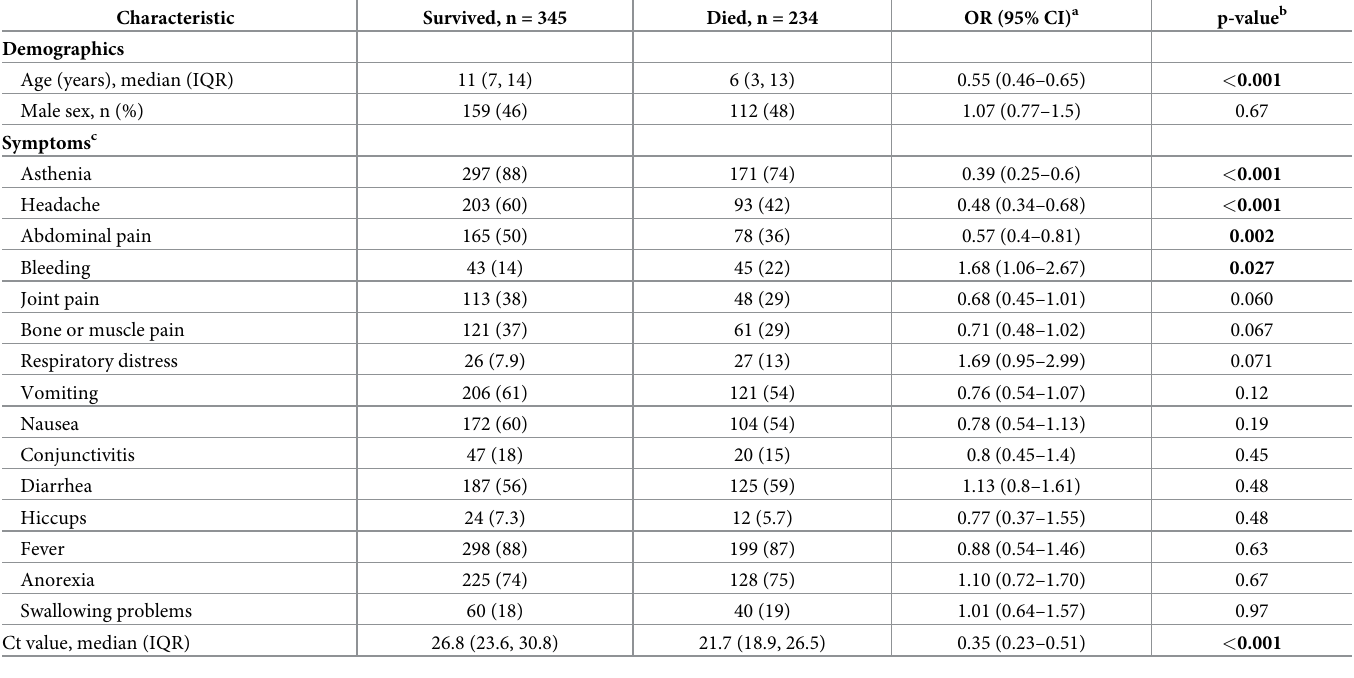
Table 1. Demographic and clinical characteristics of patients in the West Africa derivation cohort.